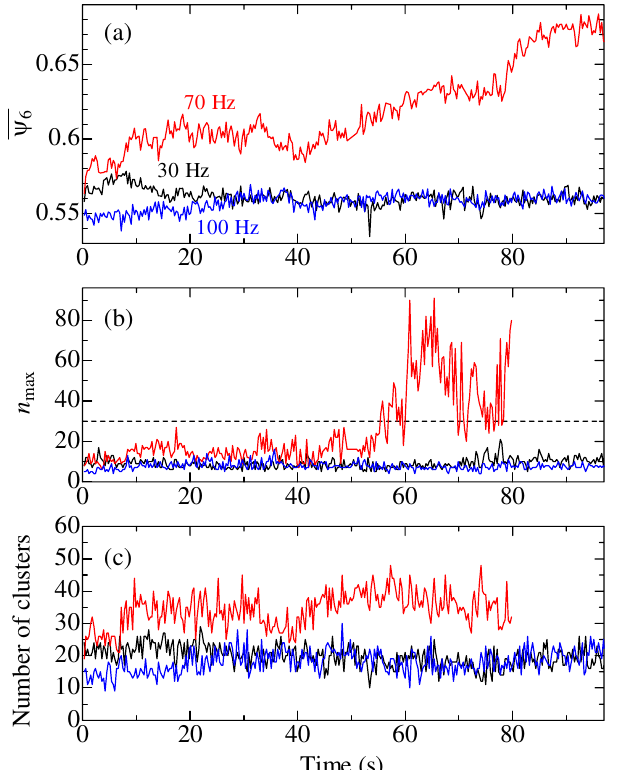
Figure 2. Evolutions of ( a ) averaged value of ψ 6 i , ( b ) the number of particles composing the largest crystalline cluster, and ( c ) the number of the crystalline clusters. A dashed line in ( b ) indicates n max =